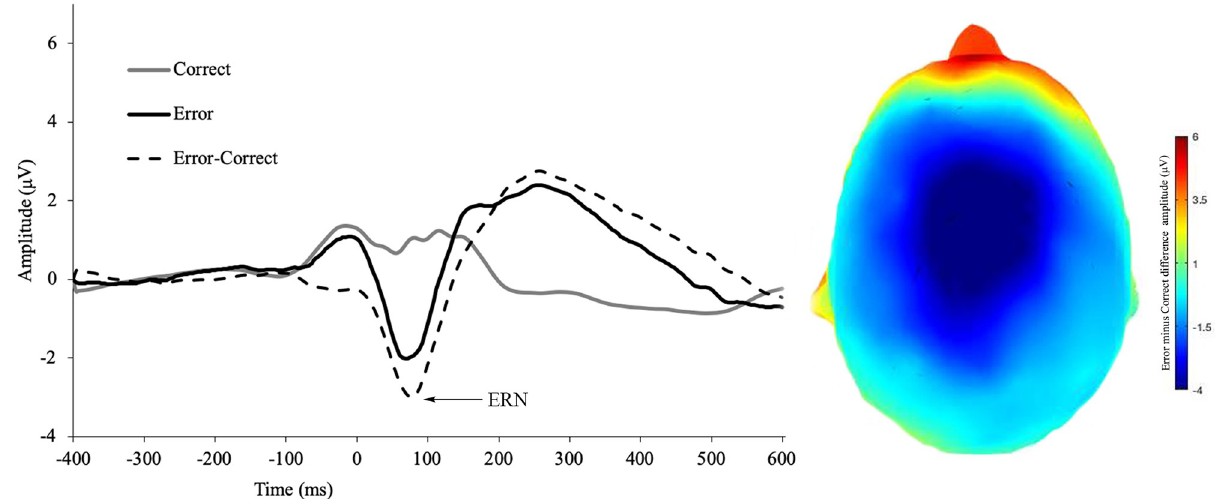
Fig 2. ERN for erroneous responses, correct responses, and the difference wave during the flanker task. Scalp distribution of the difference wave (incorrect minus correct responses).